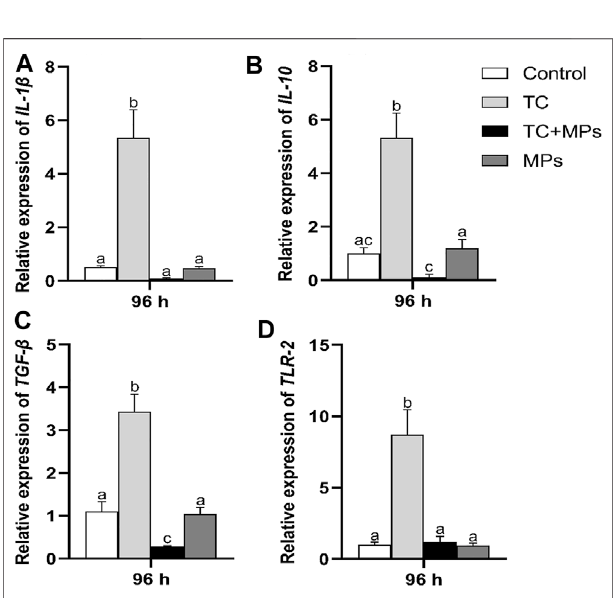
FIGURE 4 | Bar graph presentation of relative expression of immune- related genes (A) IL-1 β , (B) IL-10 , (C) TGF- β , and (D) TLR-2 in muscle of Jian carp after exposure for 96 h. Values are expressed as mean ± SD from triplicate groups. Different lowercase letters indicate statistically signi fi cant difference between treatments ( p <